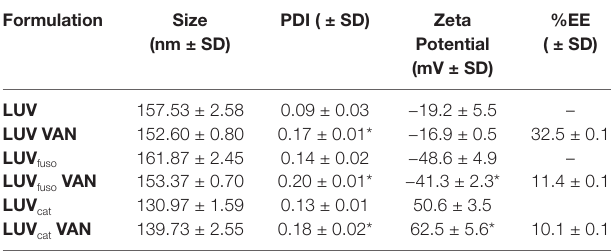
TABLe 1 | Mean ( ± SD) of the size (nm), polydispersity index (PDI), zeta potential (mV) and encapsulation efficiency (%EE) of the liposomal formulations developed in this study.